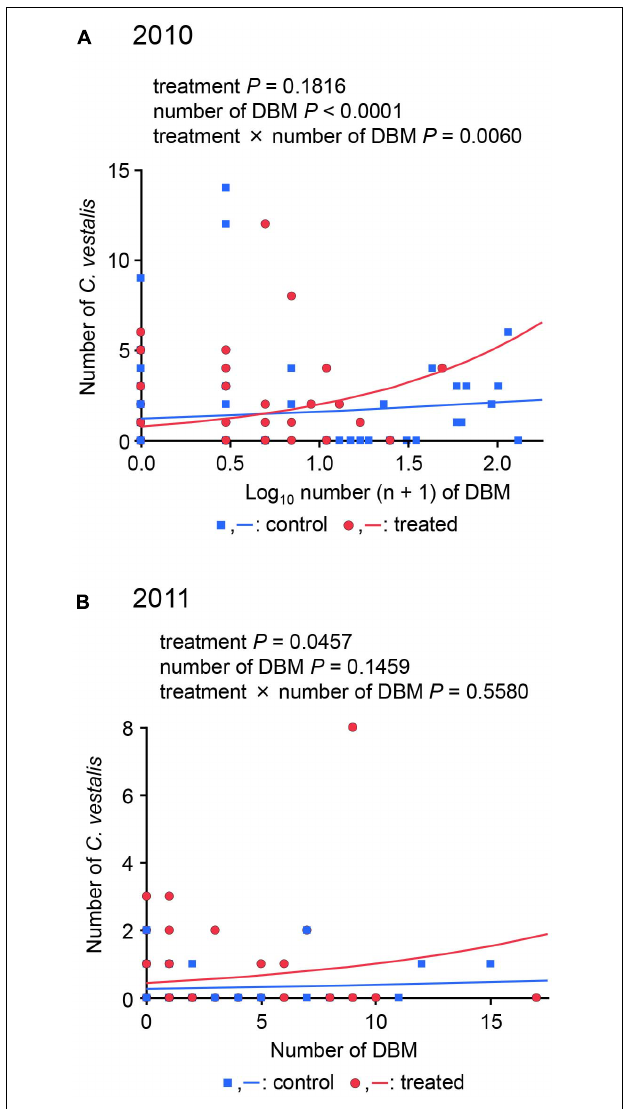
FIGURE 2 | Poisson regression analyses of the number of diamondback moth larvae and Cotesia vestalis cocoons in 2010 (A) and 2011 (B) .